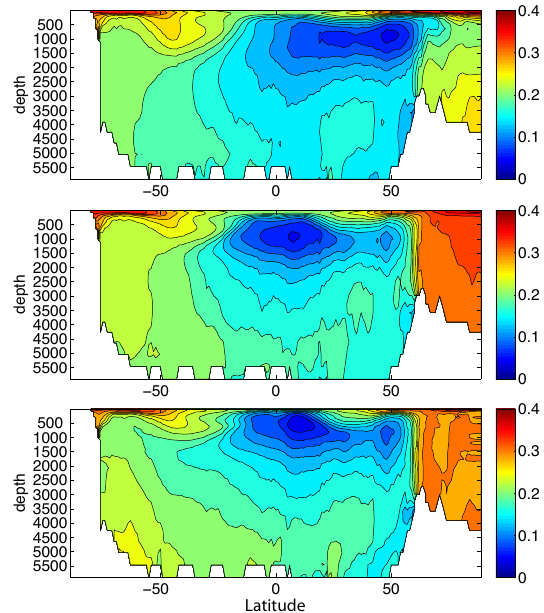
Figure 4. Zonal mean oxygen concentration (in molm − 3 ) from Garcia et al. (2010) (bottom panel) and from the two 500-year sim- ulations (see Fig. 3 caption for details) using the K gm , K σ , and K d estimate (middle) or the K gm , K σ , and K d first guess